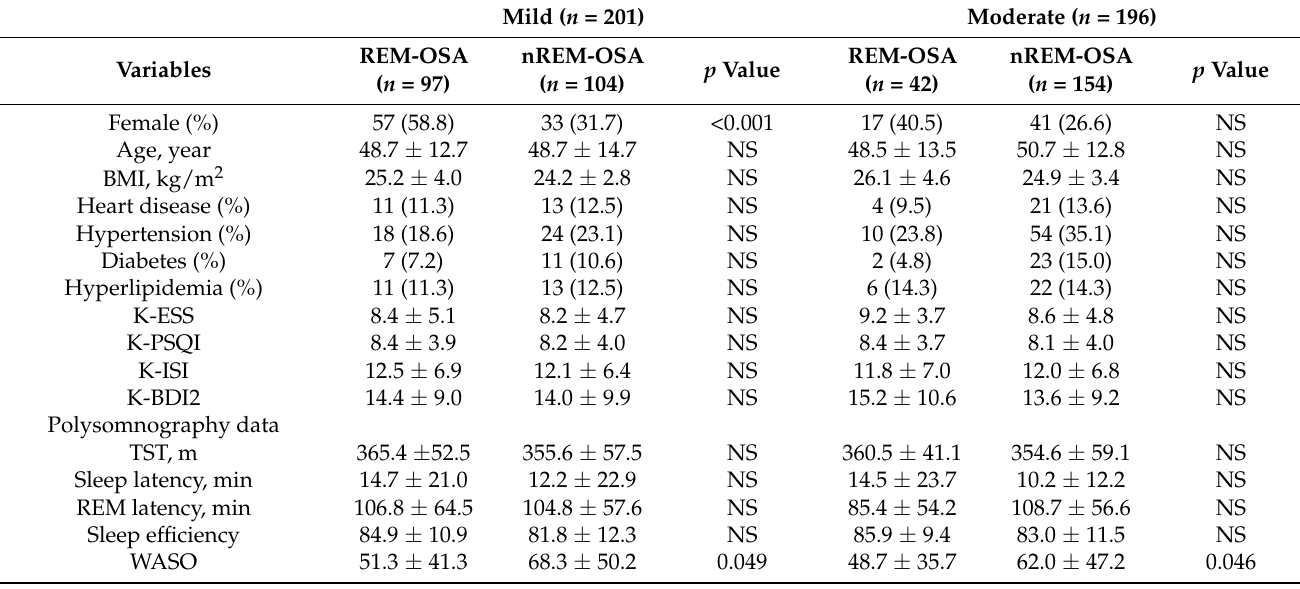
Table 3. Clinical characteristics and polysomnographic data for REM-OSA and nREM-OSA patients according to OSA